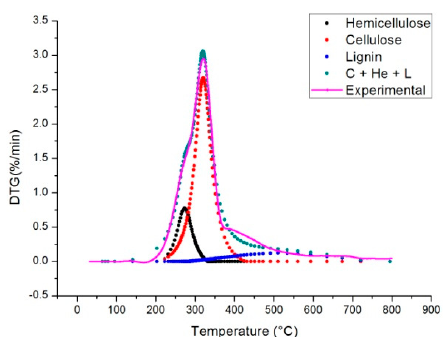
Figure 7. Comparison between experimental DTG data and the combined kinetics of the three-parallel-reaction model (Heating Rate 5 °C/min).